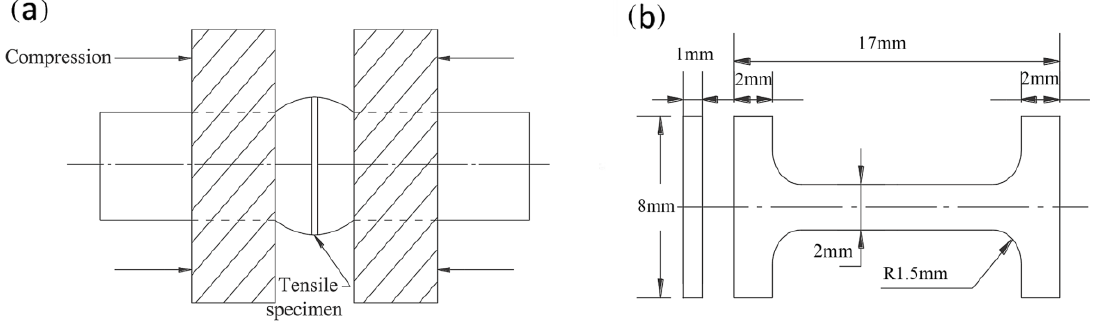
Figure 2. Schematically samples for TMCP simulation ( a ) and wire-cut for tensile testing ( b ).